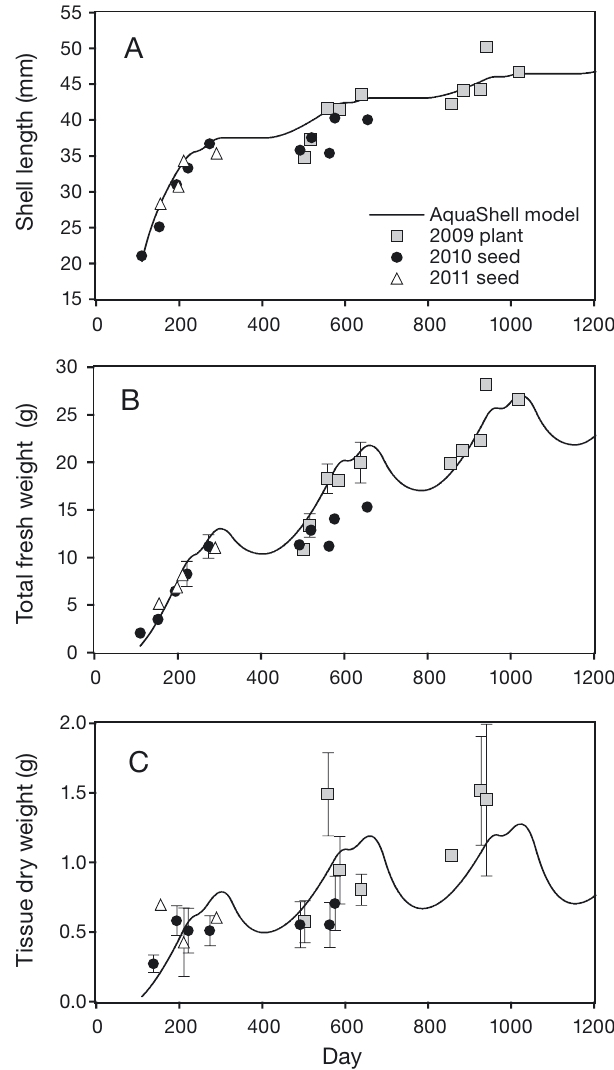
Fig. 5. Simulation of (A) shell length, (B) total fresh weight and (C) tissue dry weight over a full growth cycle. Error bars are